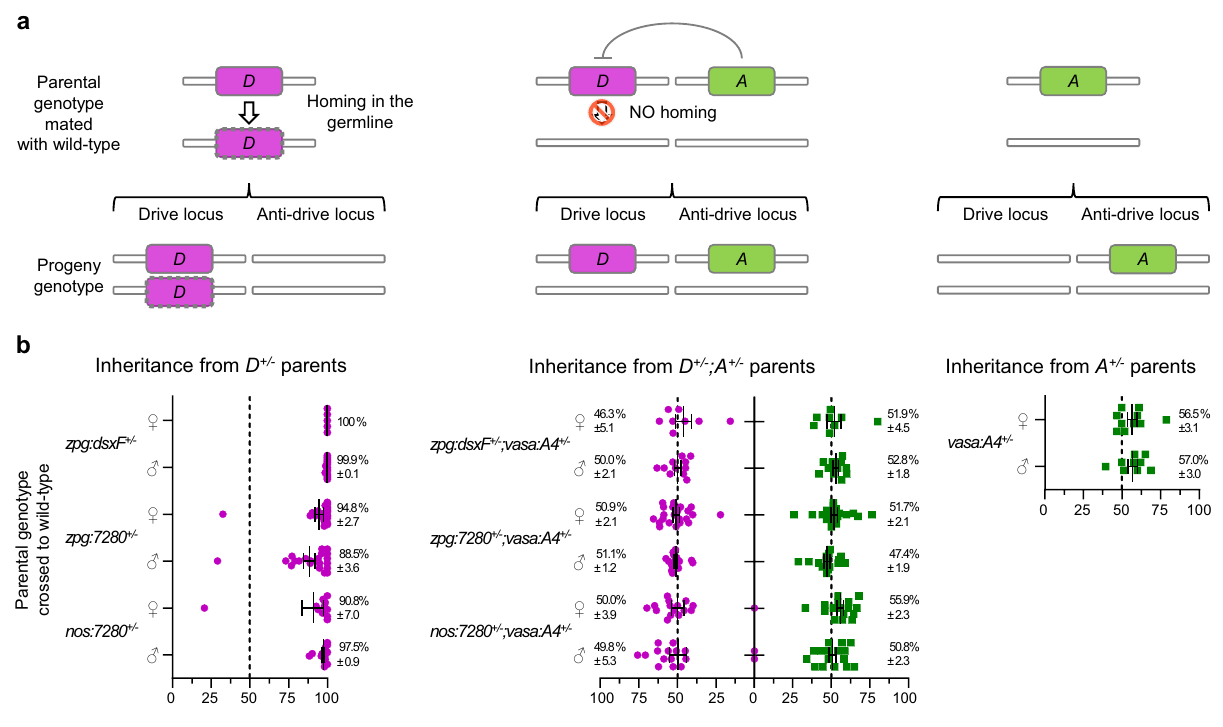
Fig. 2 Germline expression of anti-CRISPR protein AcrIIA4 causes complete inhibition of gene drive homing. a Schematic representation of gene drive homing in the germline of individuals carrying one copy of the drive allele ( D + / − ): Cas9 – gRNA-directed cleavage of the insertion site on the homologous wild-type chromosome is repaired via homology-directed repair (HDR), using the drive-carrying chromosome as template, resulting in the D allele being copied (the new drive copy is indicated as dashed magenta rectangle) and transmitted to most of the progeny (left). Illustration of gene drive homing inhibition in individual carrying one drive and one anti-drive copy ( D + / − ;A + / − ) as consequence of AcrIIA4-directed Cas9 – gRNA blockage, resulting in Mendelian inheritance of the D allele (middle). Mendelian inheritance of the anti-drive from A + / − individuals (right). b Scatter plots showing the percentage of larvae carrying the gene drive (RFP positive) and/or the anti-drive (GFP positive) constructs from wild-type mosquitoes crossed to transgenic females or males carrying: only the gene drive construct, con fi rming high transmission rates (up to 100%) of the D allele from each of the transgenic lines tested (left); both gene drive and anti-drive constructs, showing Mendelian inheritance of both D and A alleles (middle); only the anti-drive construct, showing expected Mendelian rates of the A allele (right). Vertical dashed lines indicate the 50% Mendelian inheritance. Error bars indicate mean percentage values and standard error of the mean of transmission rates from all biological samples assessed for each cross. A minimum of seven biologically independent samples (ovipositing females) were examined over two independent experiments for each cross, with the exception of zpg:dsxF crosses, which were examined only once. The respective raw data are provided in the Source data fi